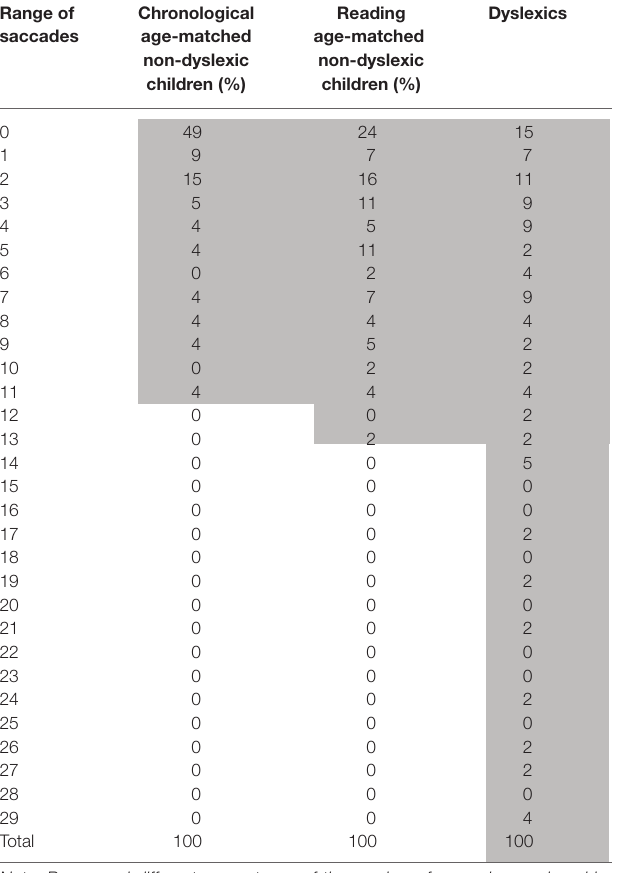
TABLE 3 | Percentage of the number of saccades for each group tested. Range of Chronological